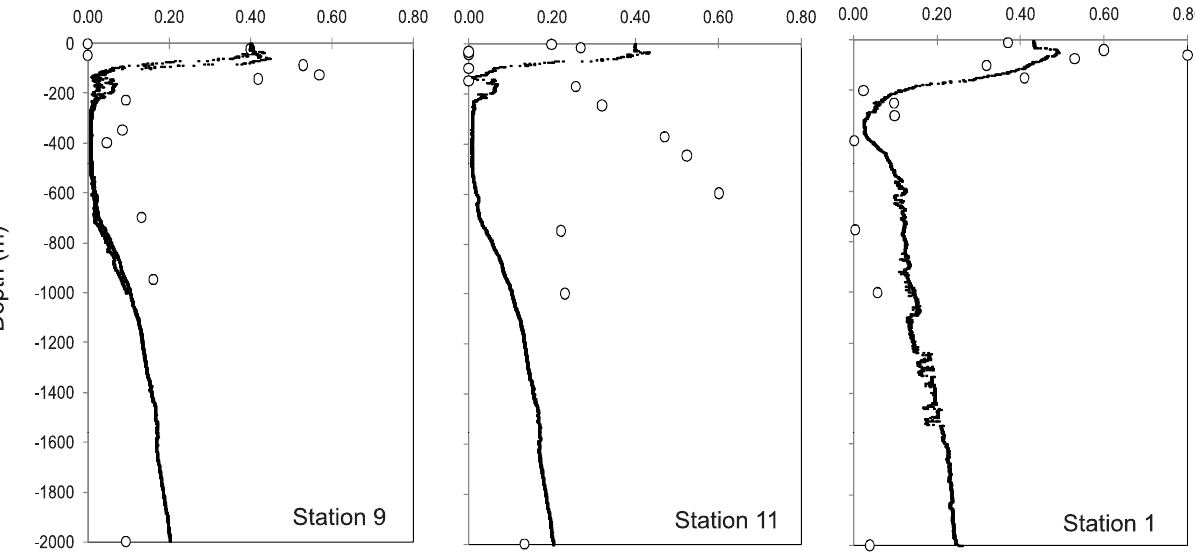
Figure 5. Vertical profiles (0–2000 m) of N 2 fixation rates (nmol L 2 1 d 2 1 ) during the 2010 cruise (R/V Atlantis). Open circles: individual N 2 fixation measurements at each depth. Black line: dissolved oxygen concentrations ( m mol Kg 2 1 ) divided by 500 to fit on the same scale.